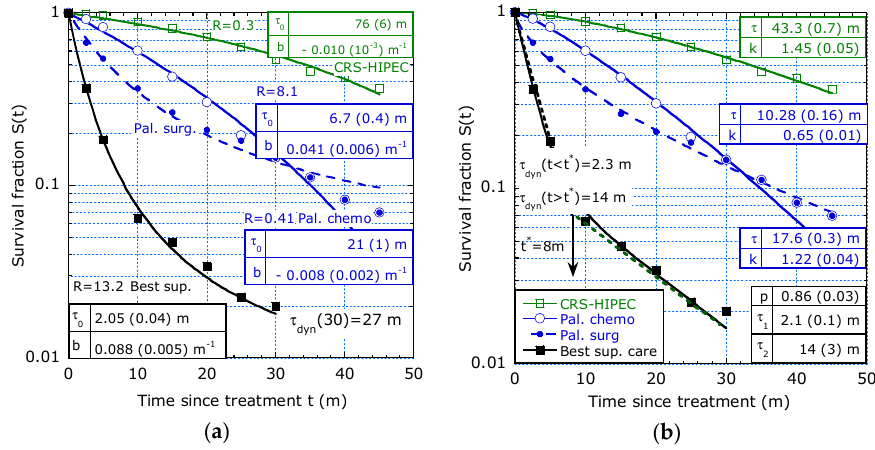
Figure 7. Comparison between models on OS of patients with PC of CRC origin: ( a ) Sliding- τ model applied to (i) CRS+HIPEC (open squares), ( ii) palliative chemotherapy (circles), (iii) palliative surgery (dots), and (iv) best supportive care (full squares) [8], Figure 2; ( b ) Weibull model applied on case: (i), (ii), and (iii). Case (iv) is fitted with the two- τ model and the piecewise linear model [8], Figure 2.